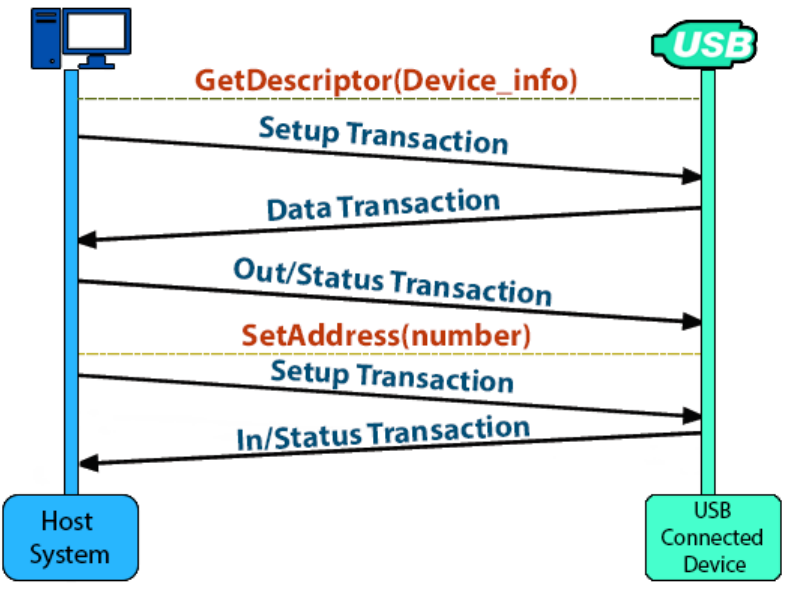
Figure 1. A USB data flow showing the enumeration phase highlighting the different transactions